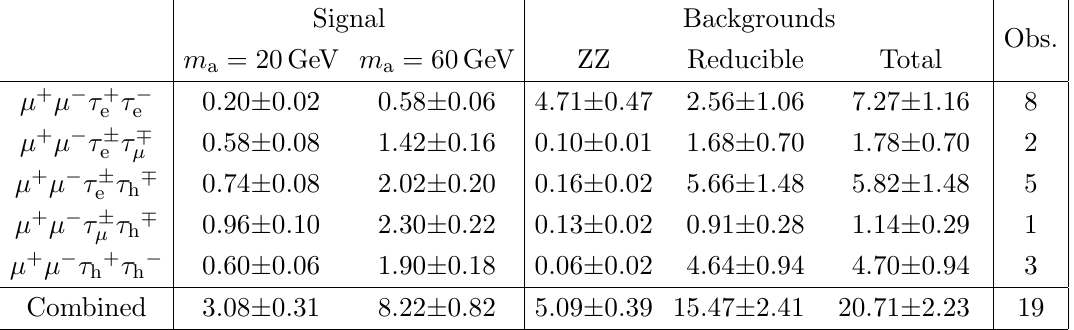
Table 5 . Expected and observed yields in the search for h ! aa ! 2 (cid:22) 2 (cid:28) decays. The signal samples are scaled with the production cross section for the SM h boson, assuming B (h ! aa) = 10% and considering decays of the pseudoscalar a boson to leptons only. Background yields are obtained after a maximum likelihood (cid:12)t to observed data, taking into account the systematic uncertainties detailed in section